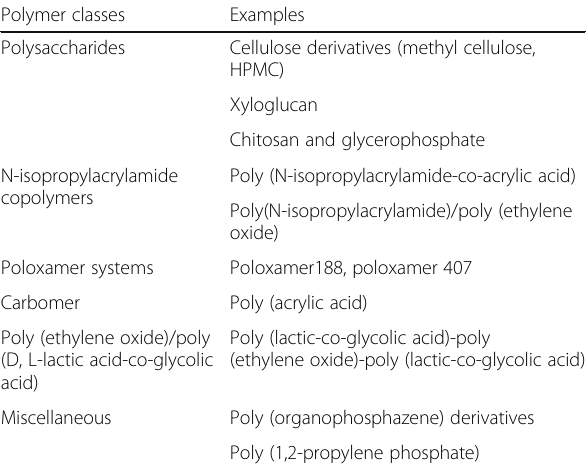
Table 4 Various thermosensitive polymers [67, 68]